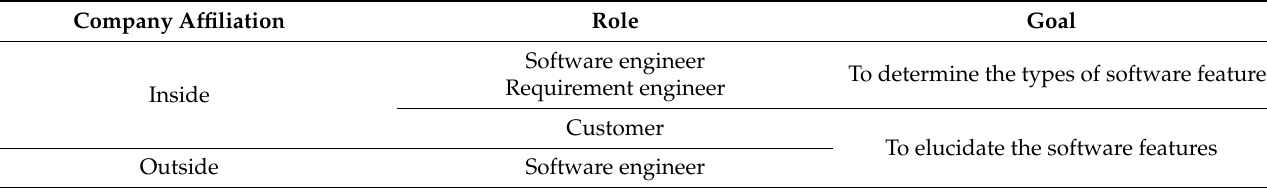
Table 3. Information about the interviewees and our